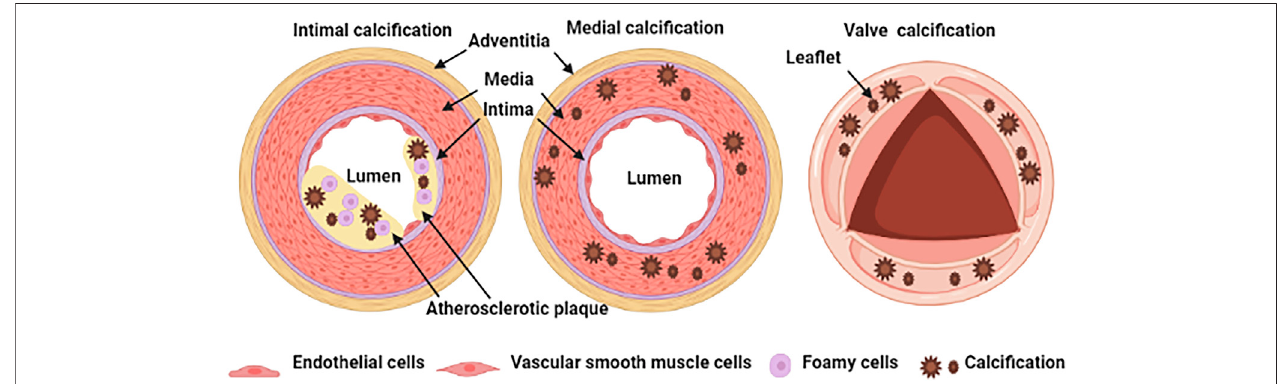
FIGURE 1 | Schematic representation of vascular calci fi cation classi fi